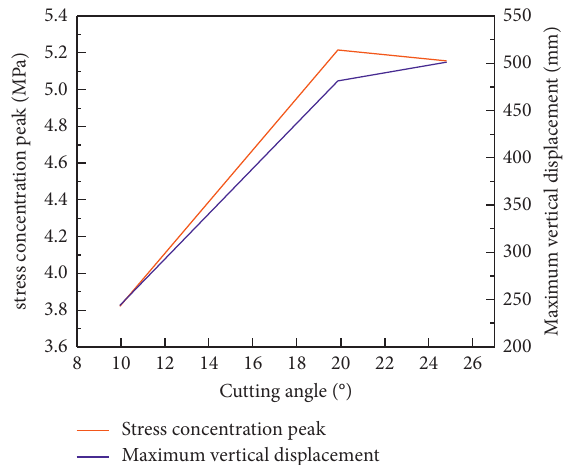
Figure 13: Pressure relief effects of different roof cutting angles.